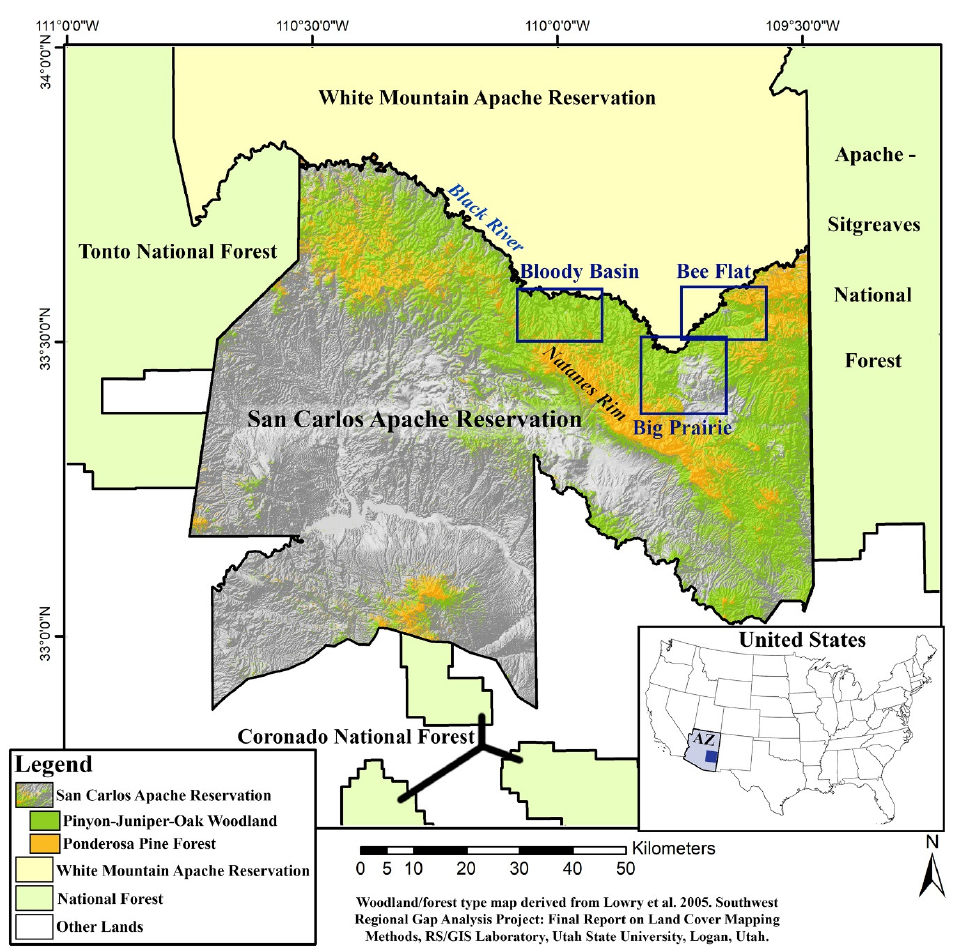
Figure 2. Map portraying the San Carlos Apache Reservation, Arizona, and surrounding area, with the 3 selected woodland study areas outlined in blue. The San Carlos Apache Reservation is shown as shaded relief map with the higher elevations colored in green and orange, representing woodlands with varying compositions of pinyon–juniper-oak and forests of ponderosa pine, the two most common woodland/forest types in the area.